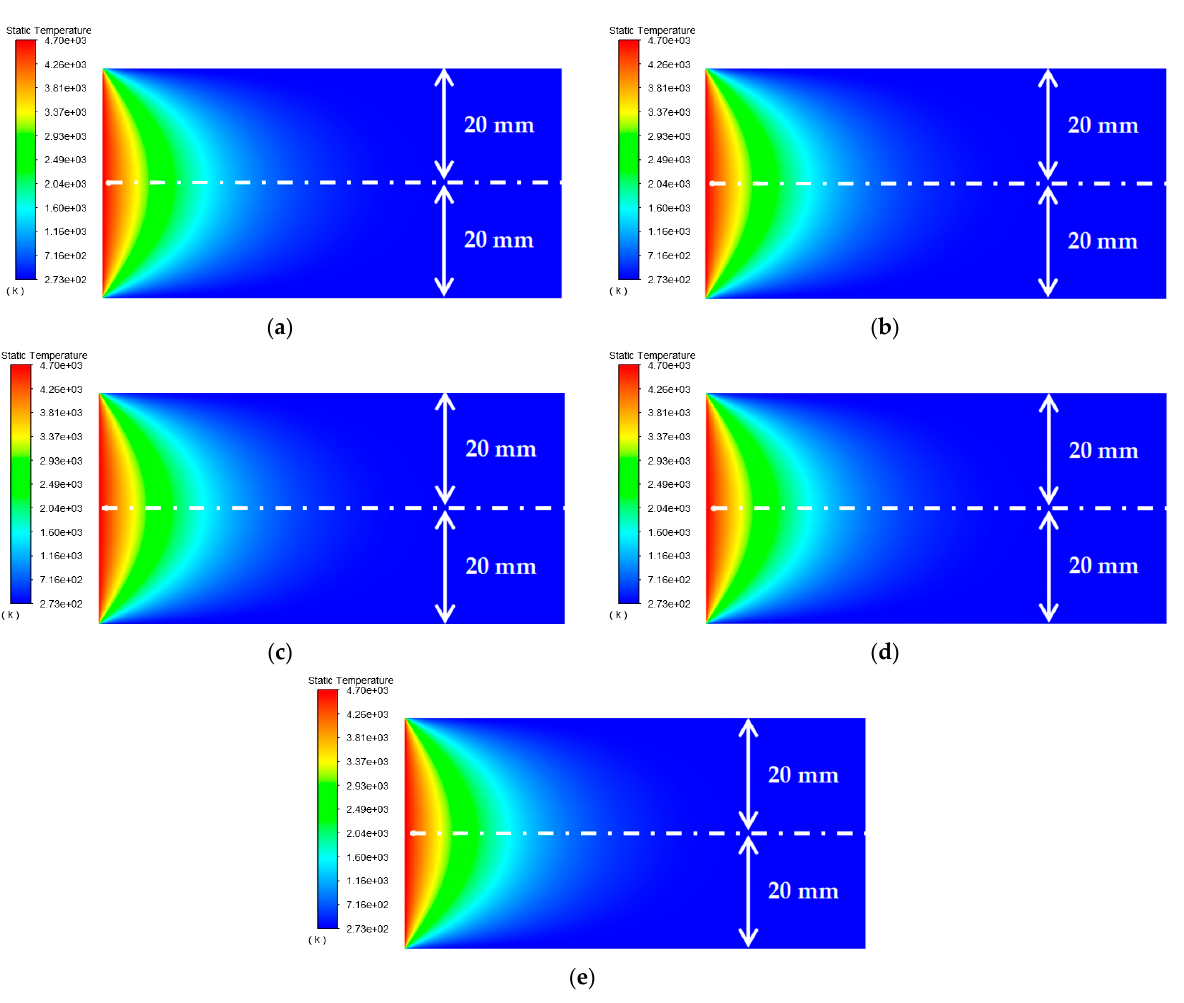
Figure 8. Surface temperature distribution diagram of platinum rhodium bushing: ( a ) b = 1.1 mm; ( b ) b = 1.2 mm; ( c ) b = 1.3 mm; ( d ) b = 1.4 mm; ( e ) b = 1.5 mm.